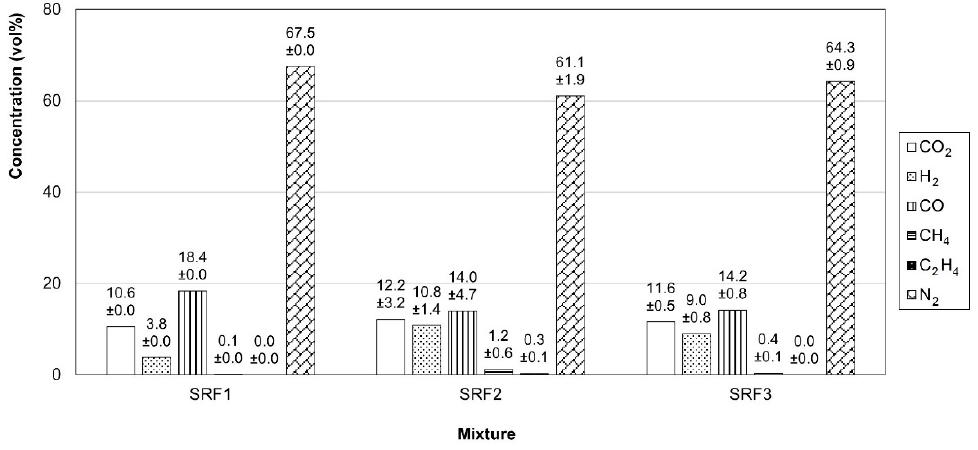
Figure 4. Composition of gas samples for each gasification test. Table 6. Properties of gas samples.